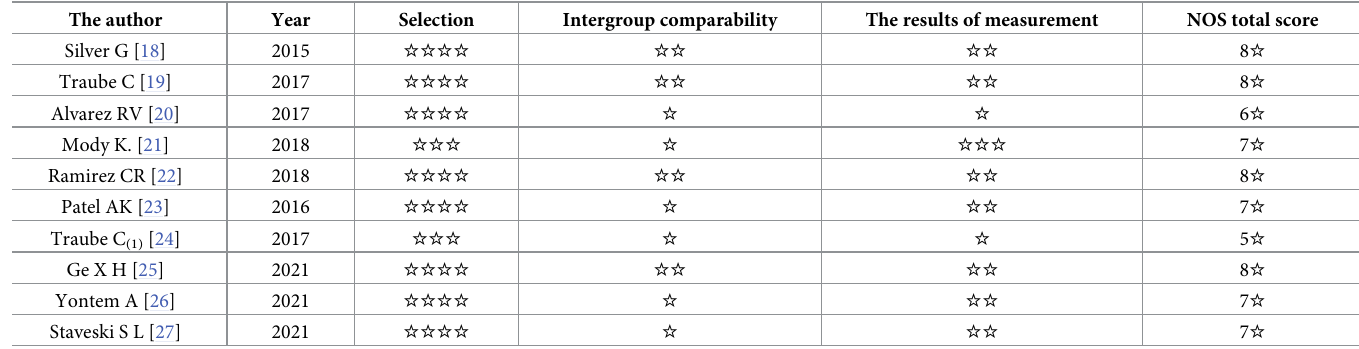
Table 2. Quality evaluation of studies.